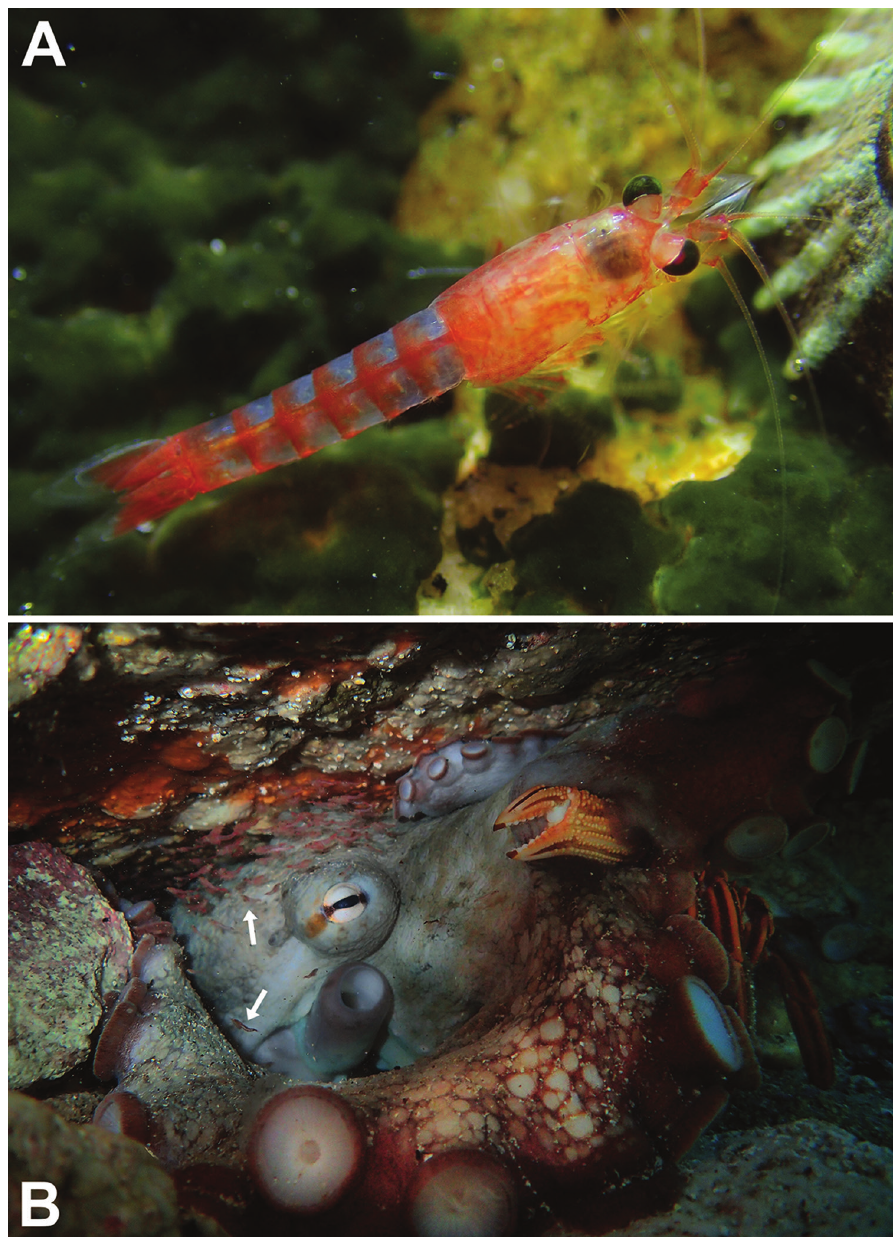
Figure 9. A subadult female of Heteromysis octopodis sp. n. with 11 mm body length from tide pool B multi-species association inside den in 3 m depth, occupied by Octopus vulgaris , to the right with the crab Guinusia chabrus ; upper arrow points to a mysid school of what we assume to be H. octopodis sp. n., lower arrow to a different but undetermined mysid species. A, B from Miller’s Point, Cape Peninsula, South Africa; in situ images by Craig Foster B image is taken of the same octopus den from which the samples were collected, but on a different